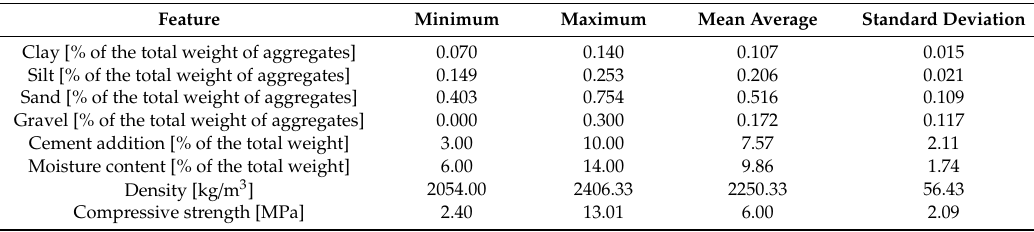
Table 3. The summary of the features’ values calculated for all 373